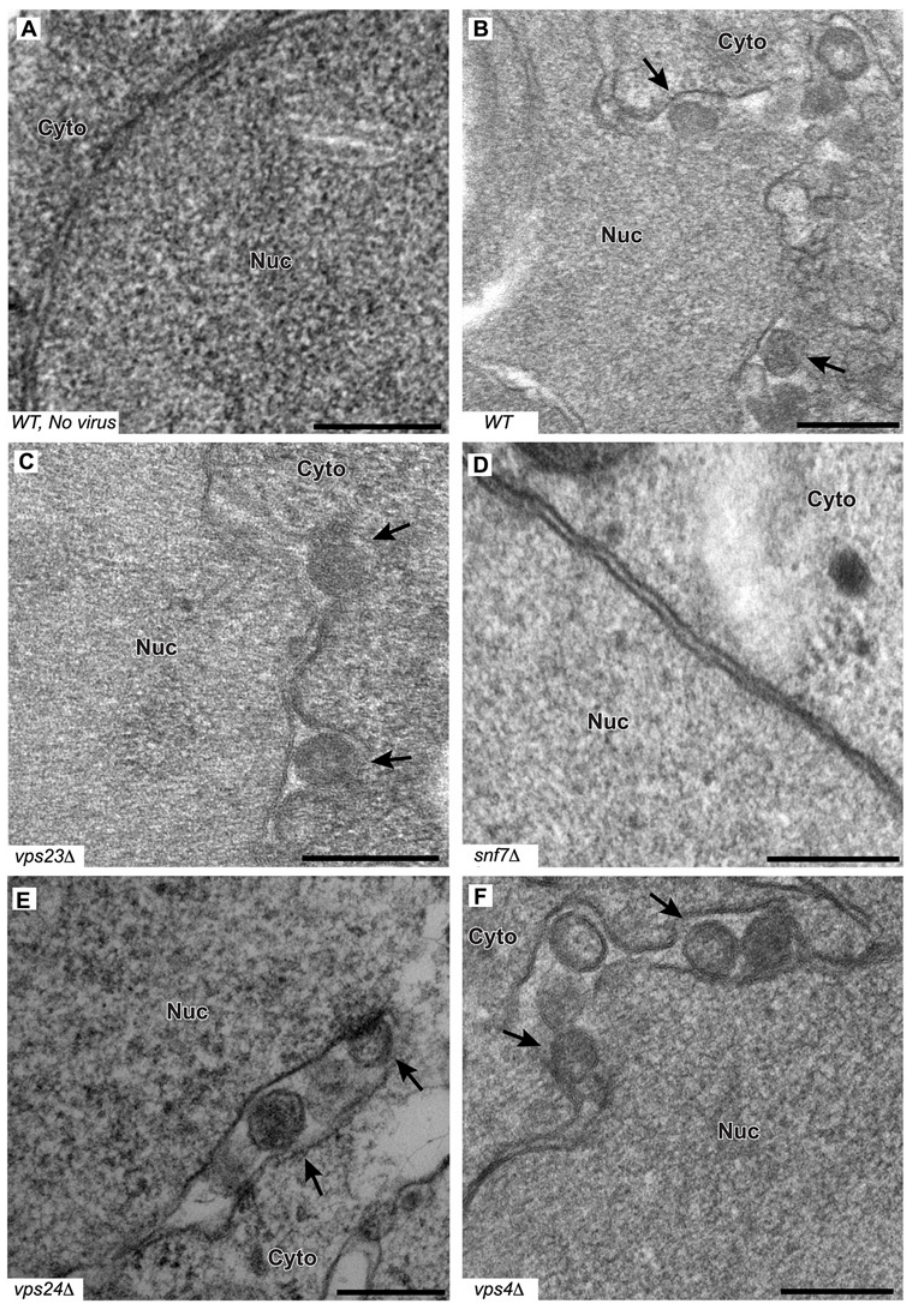
Fig 5. BMV spherule formation is abolished in the absence of Snf7p. Representative EM images of (A) non-infected yeast, (B) wt, (C) vps23 Δ , (D) snf7 Δ , (E) vps24 Δ , and (F) vps4 Δ yeast cells expressing BMV 1a. Black arrows point out individual spherular structures. Scale bars: 200 nm. Nuc: Nucleus, Cyto: Cytoplasm.